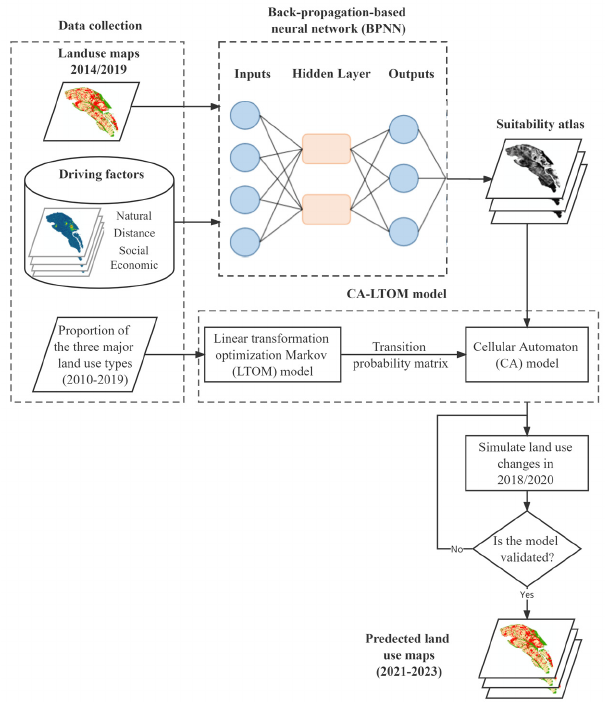
Figure 1. The framework of the loosely coupled ANN-CA-LTOM model.